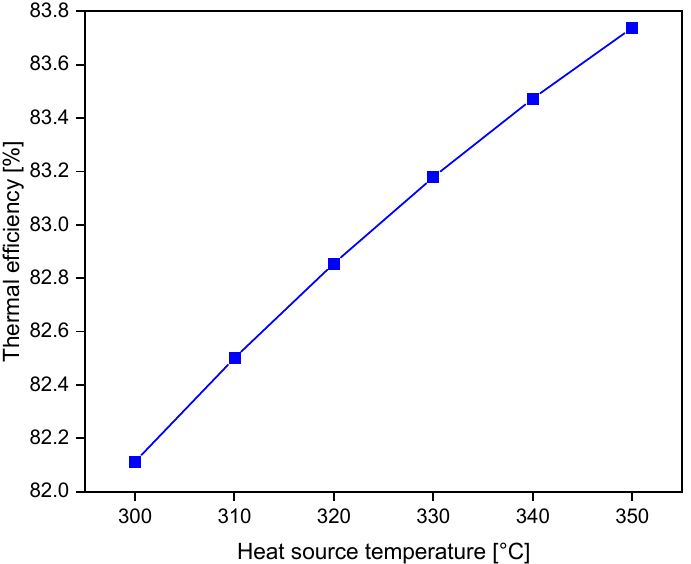
Figure 12. Variation of thermal efficiency with heat source temperature in January. Destruction of different components due to the different heat source temperatures for January is compared below. In addition to the heat exchanger, the exergy destruction of the WHS also increased with an increase in the heat-source temperature as shown in Figure 13. The exergy destruction value of the WHS in January was higher than that in August because the ambient temperature in January was much lower than that in August. A higher mass flow rate of water had to be heated in January. However, exergy destruction for other components of the system remained relatively constant.